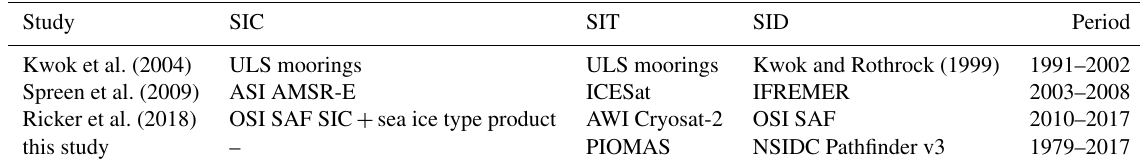
Table 1. The list of data sources used for estimates of sea ice volume flux through Fram Strait: sea ice concentrations (SIC), sea ice thicknesses (SIT), sea ice drift velocities (SID) and the time periods of the estimates. Study